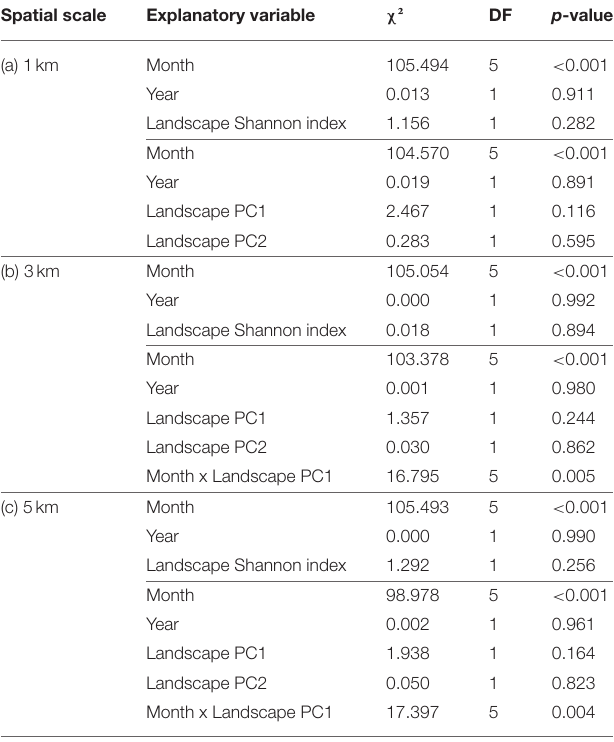
TABLE 1 | Results of the linear mixed-effect models testing the response of pollen Shannon index at the three spatial scales, i.e., (a) 1km radius buffer, (b) 3km radius buffer, and (c) 5km radius buffer around the sampling locations, to month, year, landscape Shannon index, and the interaction between month and landscape Shannon index; and month, year, landscape PC1 and PC2, and the interactions between month and landscape PC1 and month and landscape